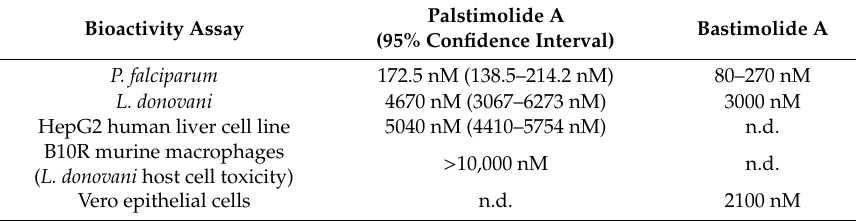
Table 2. Bioactivity of palstimolide A and bastimolide A (literature data [6]). Bioactivity